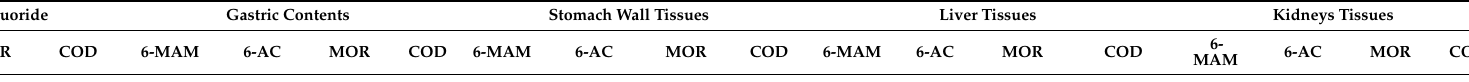
Table 5. Correlation (Spearman-Rho [ p -value]) between the heroin biomarkers and their metabolites concentration detected in 16 heroin-related postmortem cases in different postmortem specimens in the current